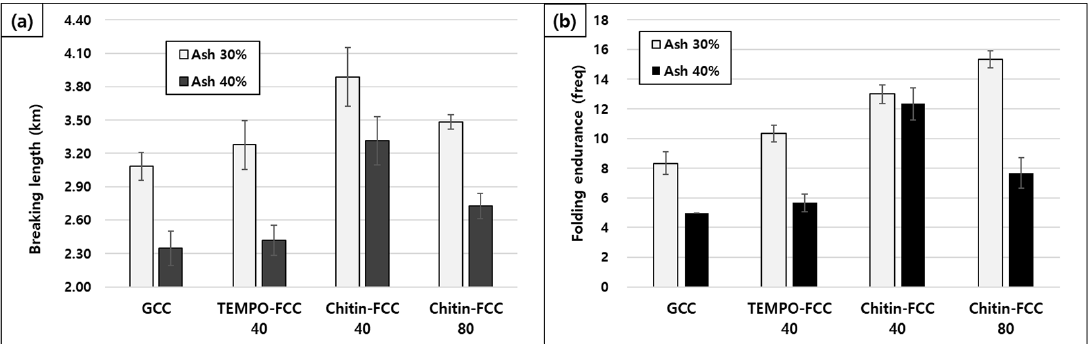
Figure 5. Bulk ( a ), Gurley stiffness ( b ), and Bekk smoothness ( c ) of the papers containing three dif- ferent fillers.